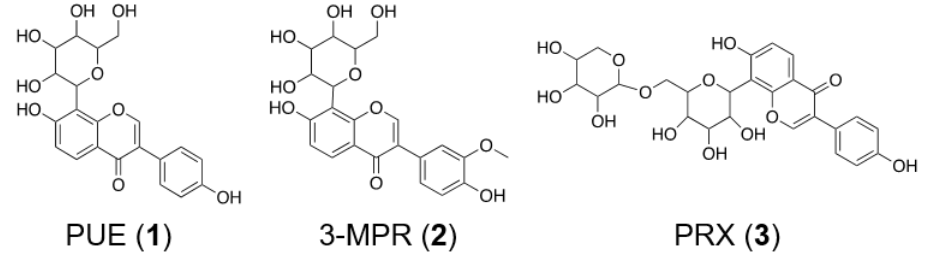
Figure 1. Chemical structures of puerarin flavones in this study.